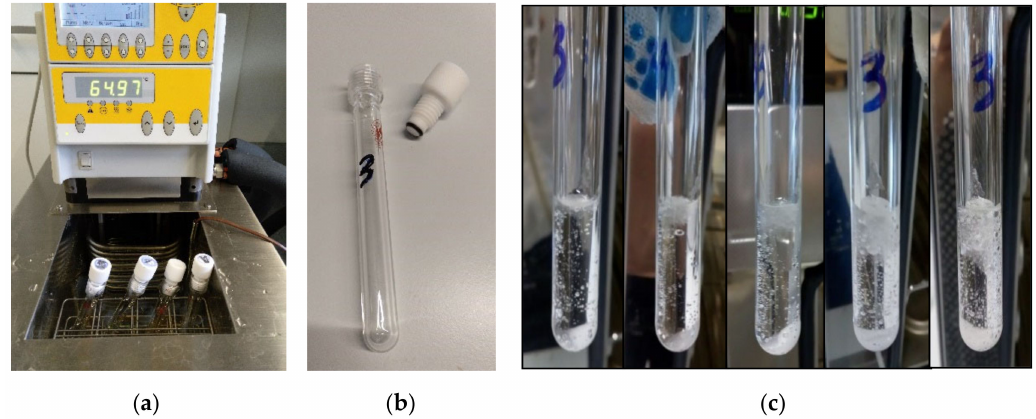
Figure 5. Pictures of stability testing device “EHU”; thermostatic bath ( a ), glass tube and cap ( b ), thermally cycled samples ( c